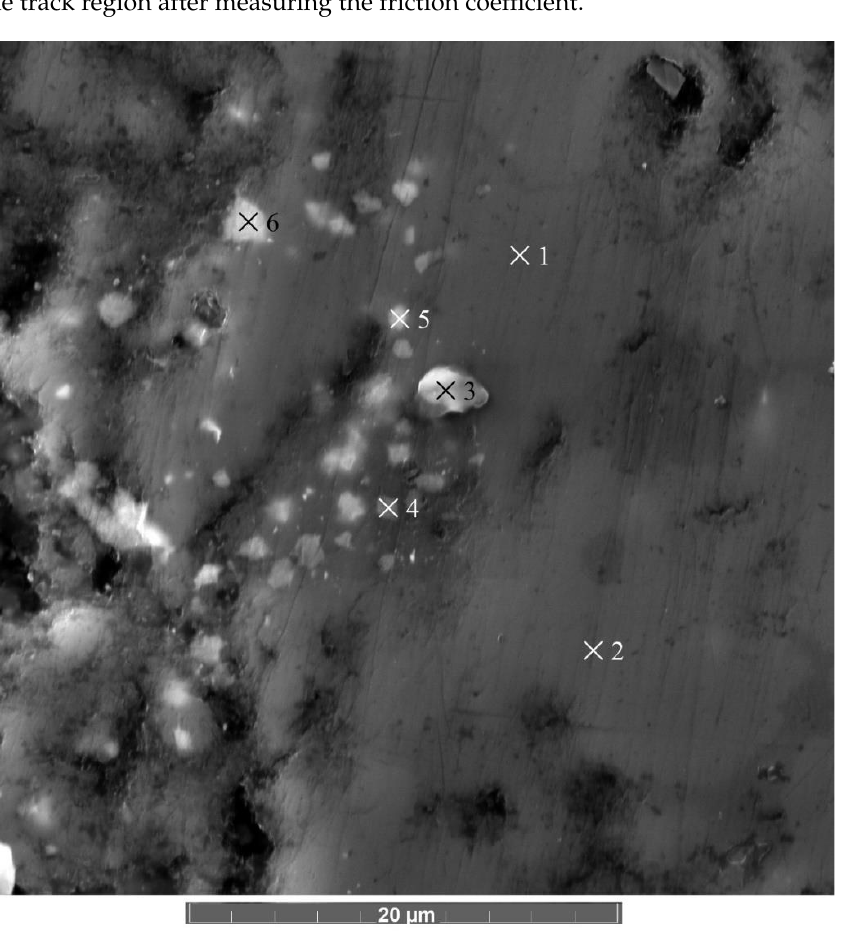
Figure 6. SEM image of the relief of the AlMgB 14 -TiB 2 composite after friction testing (on the surface, the areas where the elemental composition is determined are marked).